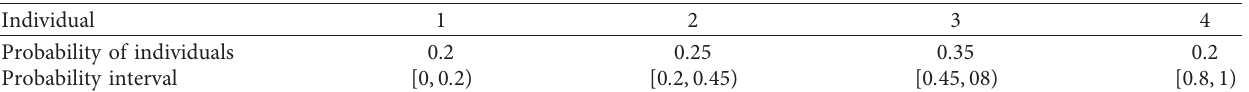
Figure 14: Flowchart of genetic algorithm. Table 7: Probability interval.